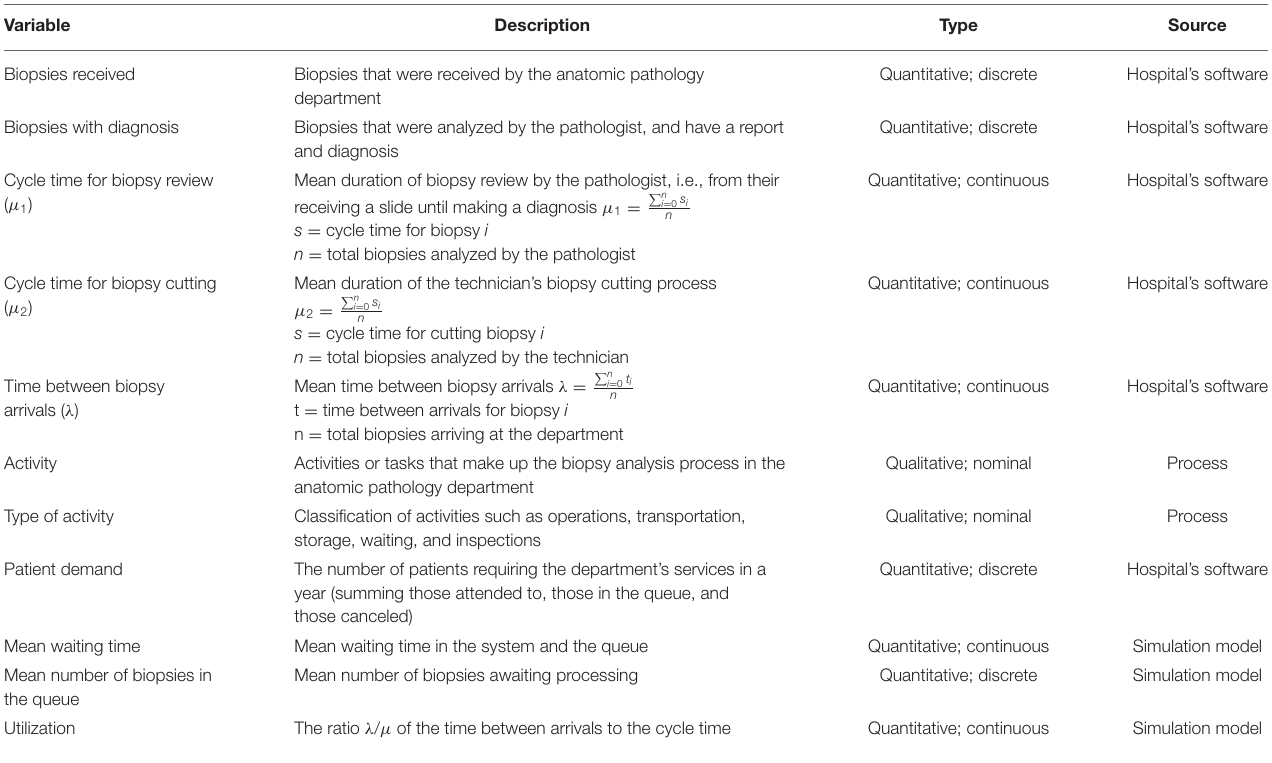
TABLE 2 | The study’s data collection